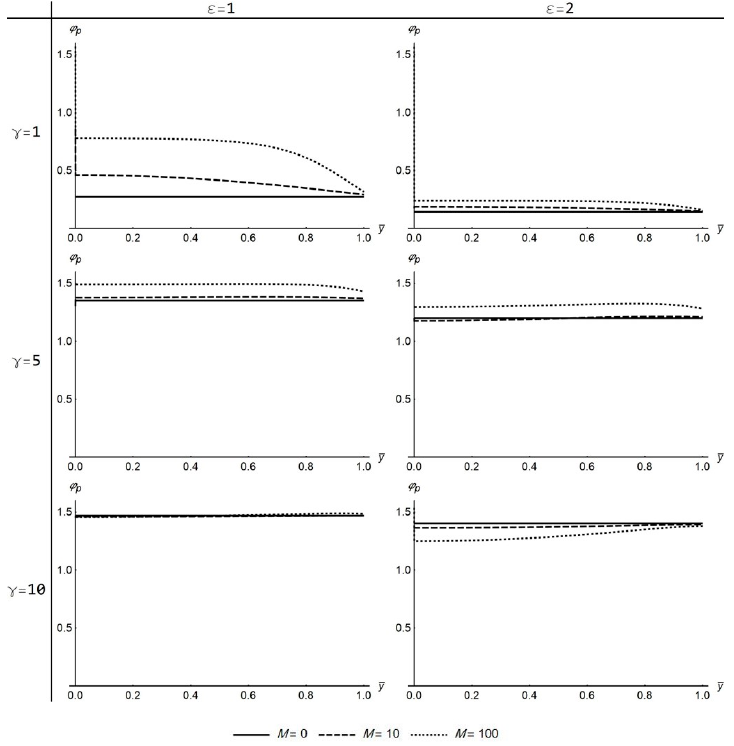
Figure 9. The profiles of 𝜑 (cid:3043) for different values of the 𝜀 , 𝛾,and 𝑀 parameters (transverse case).